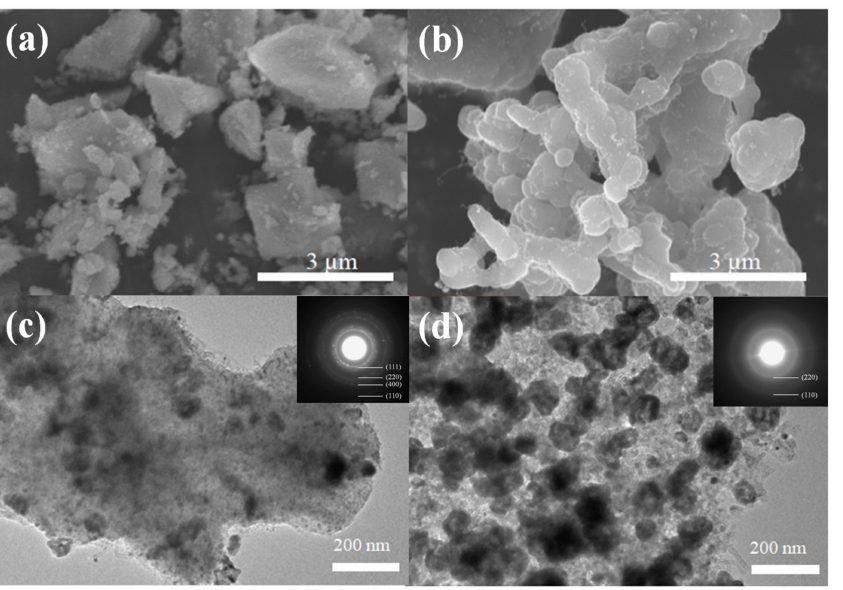
Figure 7. ( a ) SEM and ( c ) TEM images of Co/ZnO-NC; ( b ) SEM and ( d ) TEM images of Co@ZnO-NC. Insets in ( c , d ) are the corresponding selected area electron diffraction